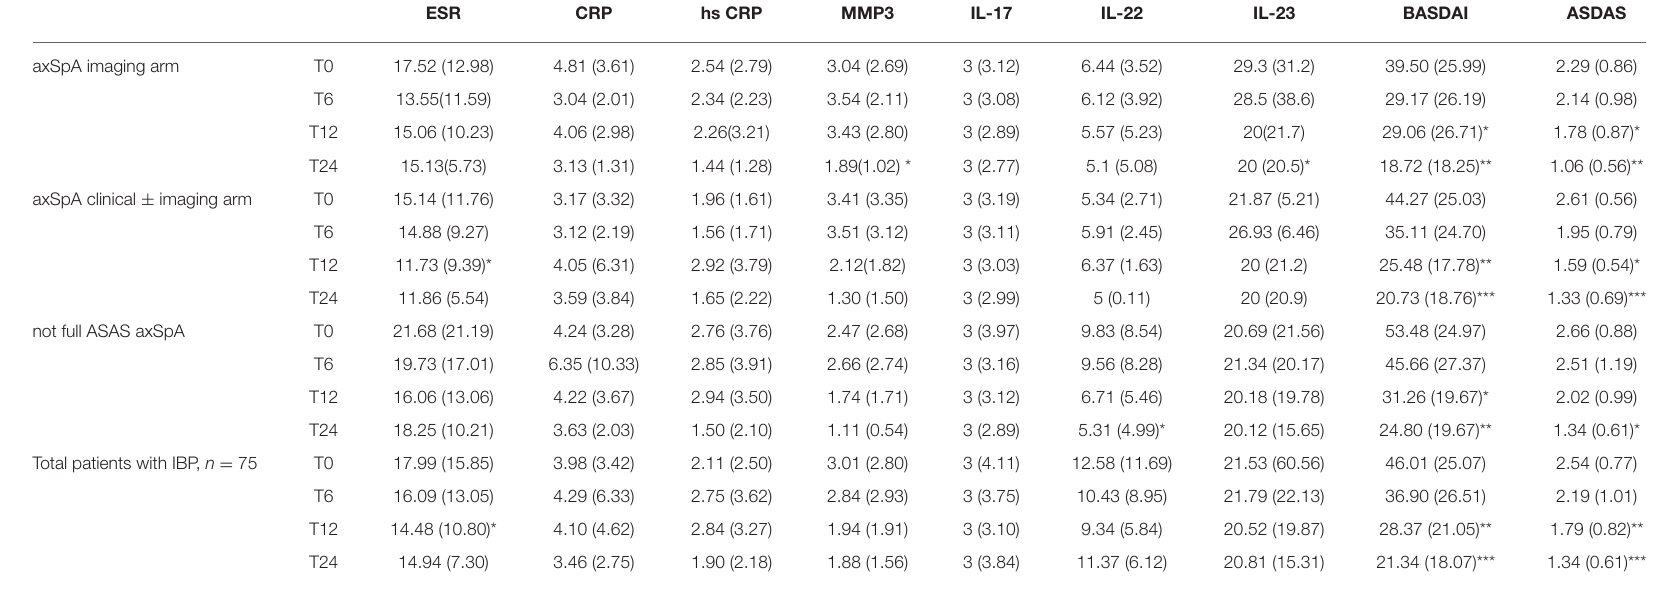
Data are expressed as mean ± SD. The test Kruskal Wallis repeated measures test and Dunn’s multiple comparison test were used *** p < 0.0001 vs. T0, ** p < 0.001 vs. T0, * p < 0.01 vs. T0. ESR, erytrocyte sedimentation rate; CRP, C-reactive protein; hs-CRP, high sensitive C-reactive protein; MMP3 matrix-metallo-proteinase 3; IL, Interleukine; BASDAI: Bath Ankylosing Spondylitis Disease Activity Index; ASDAS, Ankylosing Spondylitis Disease Activity